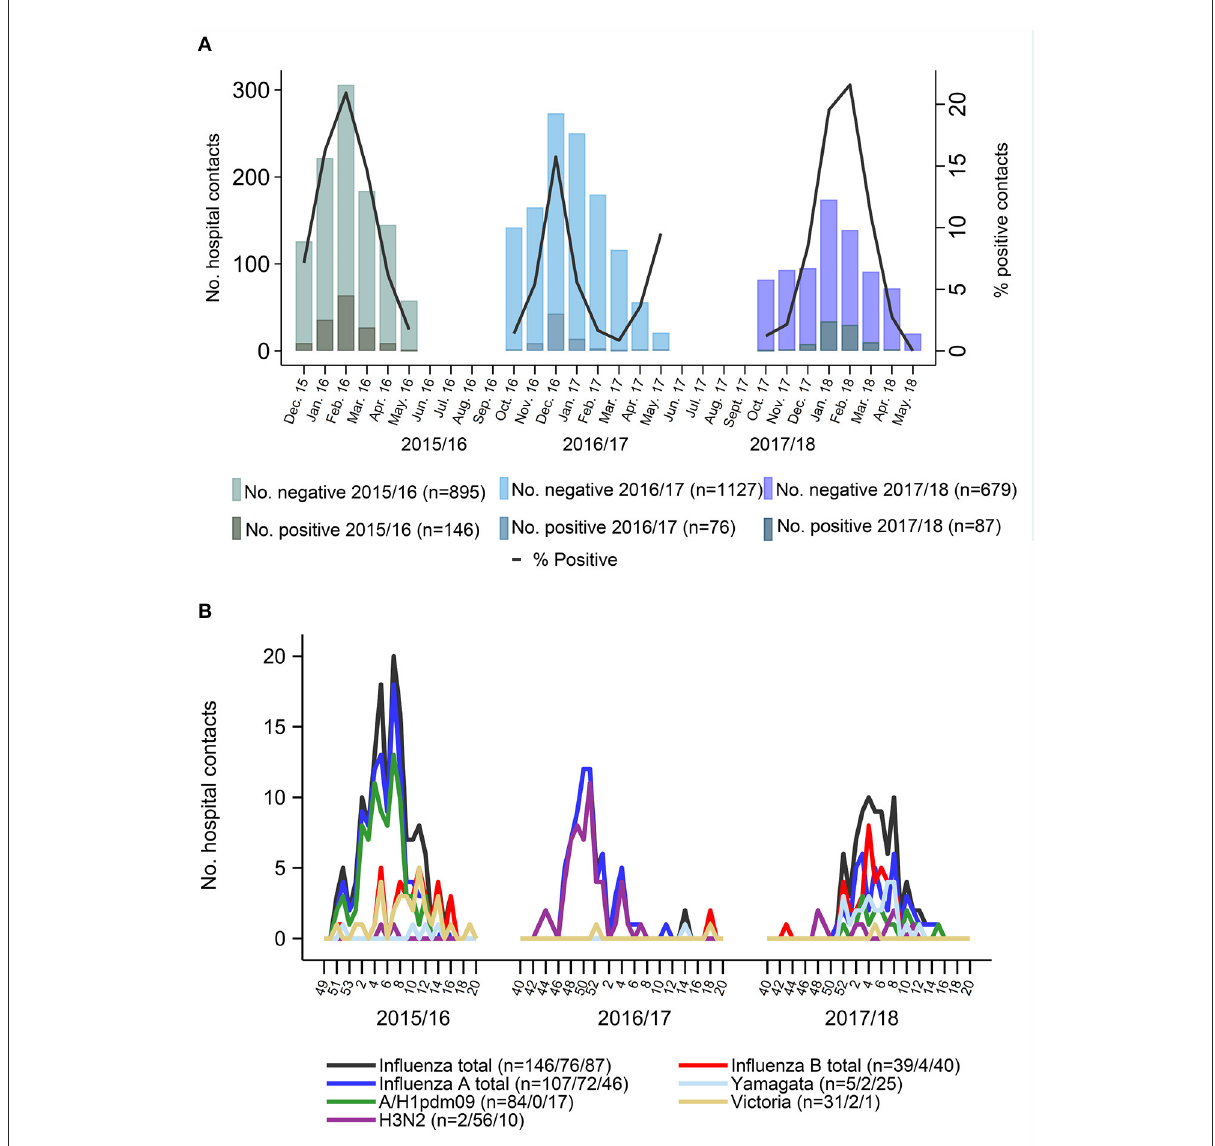
FIGURE2 (A) Number of Influenza tested participants, and positivity rate through three influenza seasons. (B) Occurrence of influenza subtypes throughout three surveillance seasons. Black lines are the sum of all influenza cases per week. Blue lines are the sum of all influenza a cases and red line is the sum of all influenza b cases. Not all cases were fully typed due to shortage of material or low viral